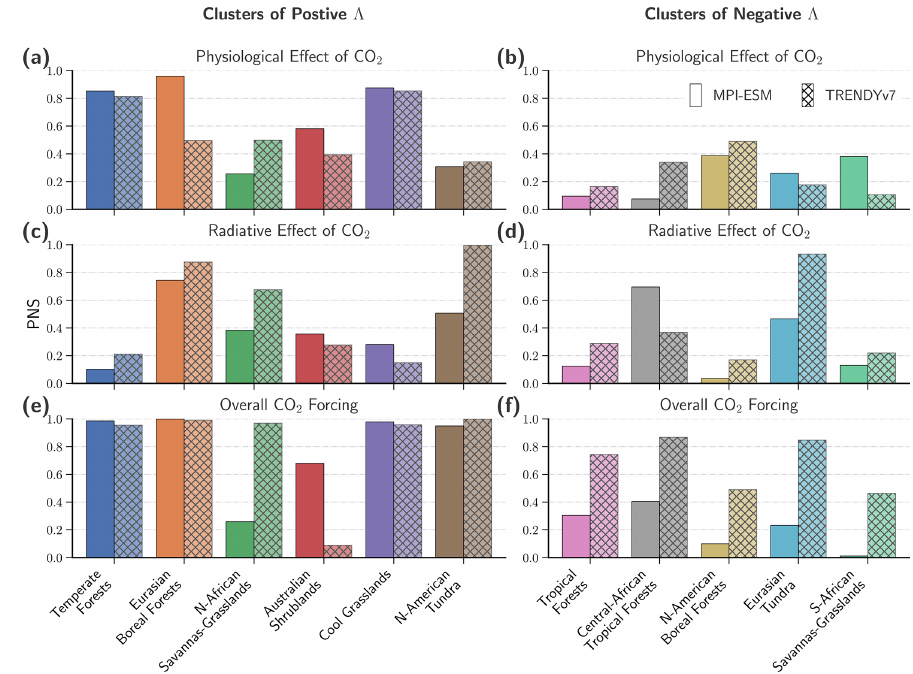
Figure 6. Probabilities of sufficient and necessary causation (PNSs) of LAI changes in response to the effects of rising CO 2 for 11 clusters. Bar charts represent the PNS of LAI changes in response to the physiological effect (a, b) and radiative effect (c, d) of CO 2 and all anthropogenic forcings (e, f) . Different colors represent the identified clusters of substantial change in LAI. Panels on the left comprise clusters that show consistent greening; panels on the right represent emerging browning clusters (observed net leaf area loss in the period 2000–2017; attribution is conducted only for significant decreasing trends; see Sect. 2 for details). The two types of bar illustrate the two different ensembles of model simulations (left: MPI-ESM, right: